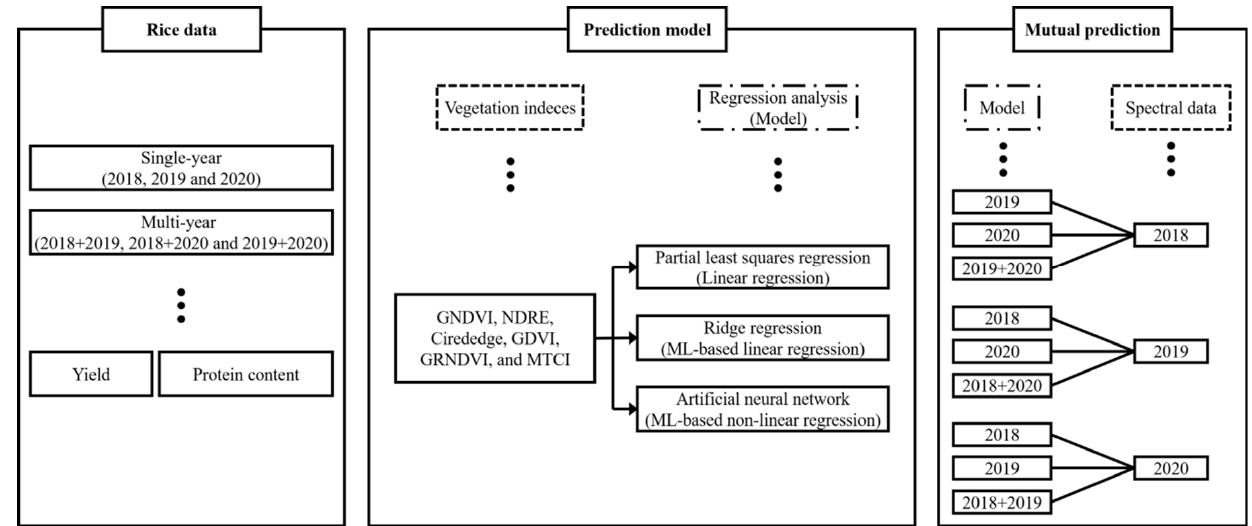
Figure 2. Development of the prediction model and mutual prediction. Table 2. Vegetation indices calculated from the reflectances of five spectral bands of rice canopies extracted from multispectral